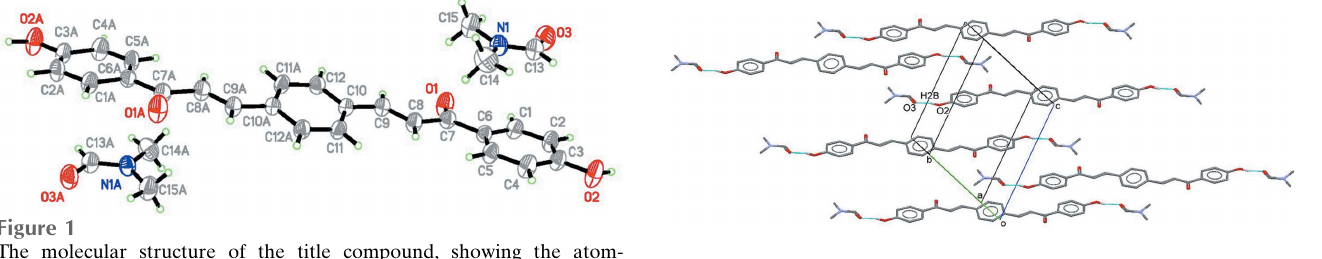
Figure 2 Partial crystal packing, showing the O—H (cid:2)(cid:2)(cid:2) O hydrogen bonds (Table 1) between the bischalcone and DMF solvate molecules.